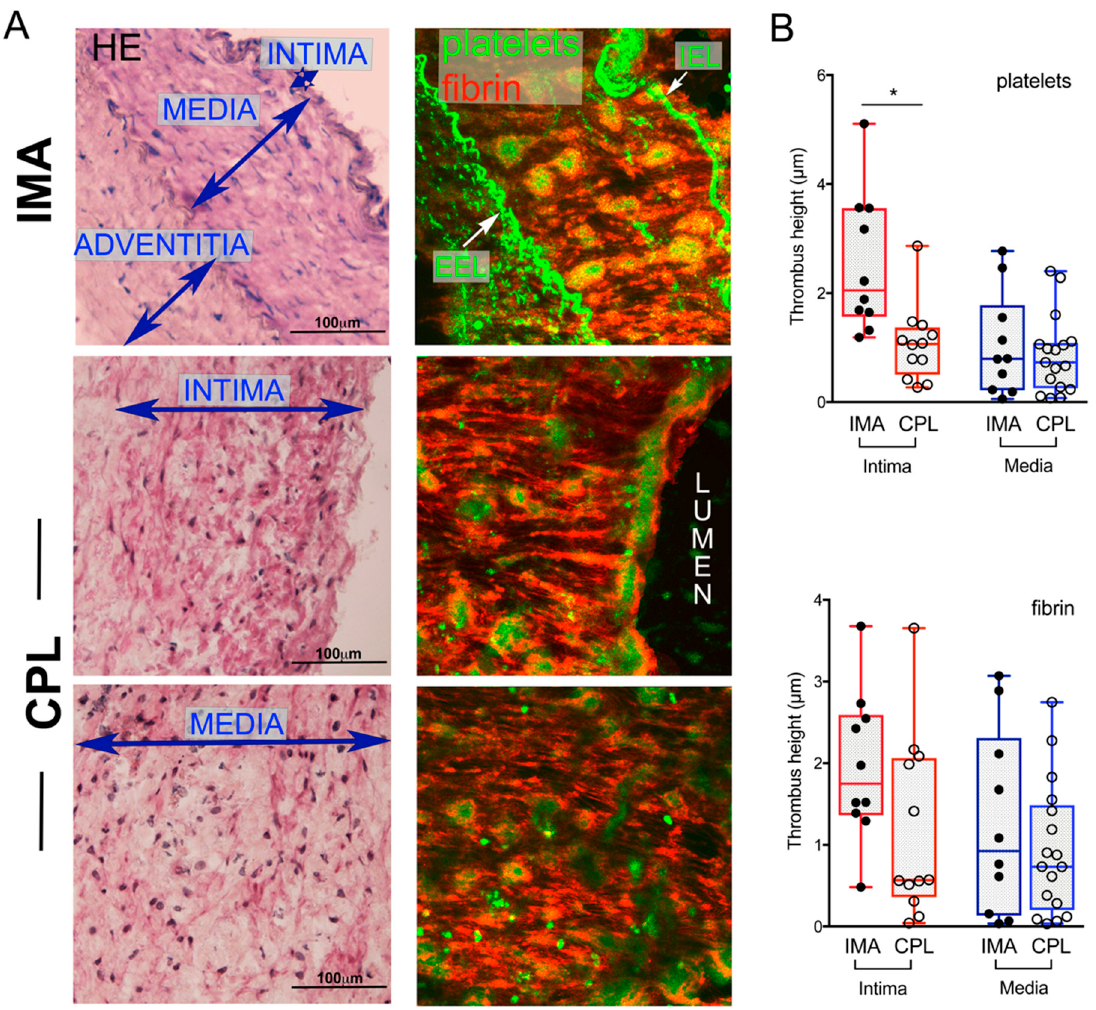
Figure 1. Thrombus formation over arterial tissue sections. Representative images from internal mammary artery (IMA) and carotid artery plaque (CPL) fields are shown ( A ). Histology (hematoxylin/eosin, A left column) and corresponding post-blood flow 2D projections from colorized Z-sections ( A right column) show the presence of not homogeneously distributed platelet aggregates over the vascular walls. IEL: internal elastic lamina, EEL: external elastic lamina. Quantification of platelets aggregates ( B , top) and fibrin deposition ( B , bottom) over the layers of 10 IMA and 17 CPL in blood flow experiments are compared. Not all the layers were available for sampling in all the CPL. Data are presented as boxes (5–95 percentile) and dots indicate the mean value from 3 to 14 fields/sample; values showing thrombus height (volume/ROI area) are presented. Asterisks indicate significant differences obtained by non-parametric Kruskal–Wallis analysis. * p value < 0.05 is considered significant.